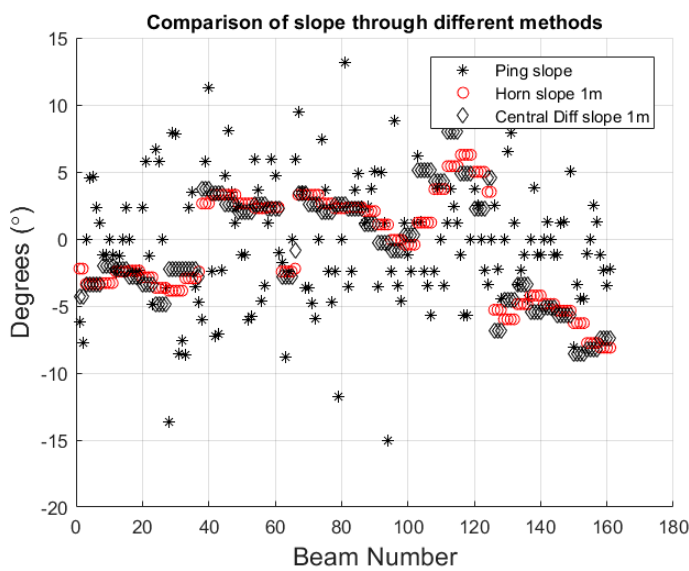
Figure 11. Comparison of slopes from three different estimation methods: “Ping” method (black dots), where all the soundings from a ping are used to compute across-track slope show large differences, from “Horn” (red circles) and “central difference” (black diamonds) methods, where 1 m grid cell size bathymetry is used to compute across-track slopes.